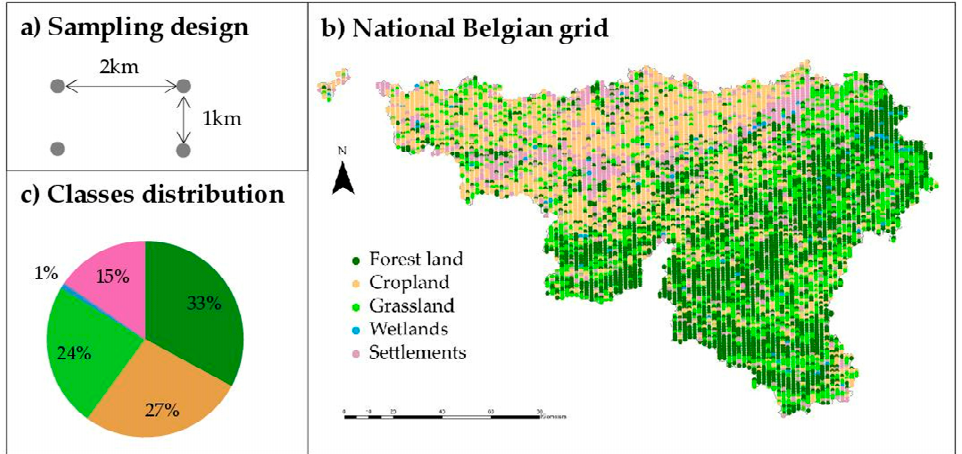
Figure 3. Distribution of the training data in Wallonia, Belgium. ( a ) The original Land Use/Cover Area frame statistical Survey (LUCAS) points were composed of 1206 points distributed all around Wallonia (forest land = 324 points; cropland = 339 points; grassland = 418 points; wetlands = 15 points; settlements = 110 points). To avoid a class imbalance problem, the location of some points was modified. ( b ) After the modification, the distribution of the points was: forest land = 270 points; cropland = 296 points; grassland = 268 points; wetlands = 146 points; settlements = 226 points. ( c , d ) show a pie chart of the classes distribution for the original and modified LUCAS points.